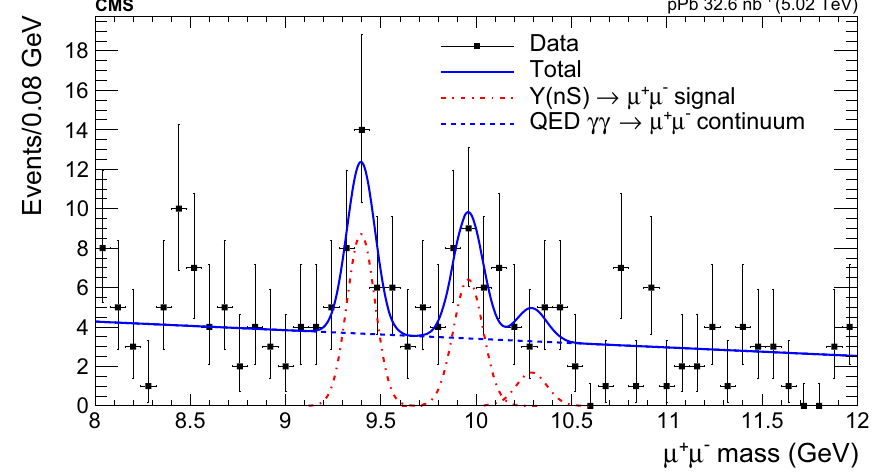
Fig. 2 Invariant mass distribution of the exclusive muon pair candidates in the range 8 < m μ + μ − < 12GeV that pass all the selection criteria, fitted to a linear function for the two-photon QED continuum (blue dashed line) plus three Gaussian distributions corresponding to the ϒ( 1S ) , ϒ( 2S ) , and ϒ( 3S ) mesons (dashed-dotted-red